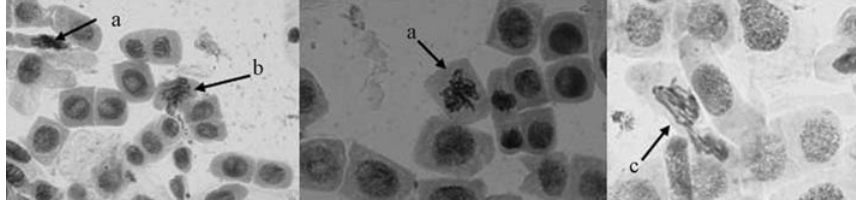
Figure 1 - Chromosomal aberrations (arrowed) induced in Allium cepa root tips by the pharmaceutical effluent. (a) sticky chromosomes, (b) chromo- somes with spindle disturbance, (c) disoriented chromosomes. Magnification